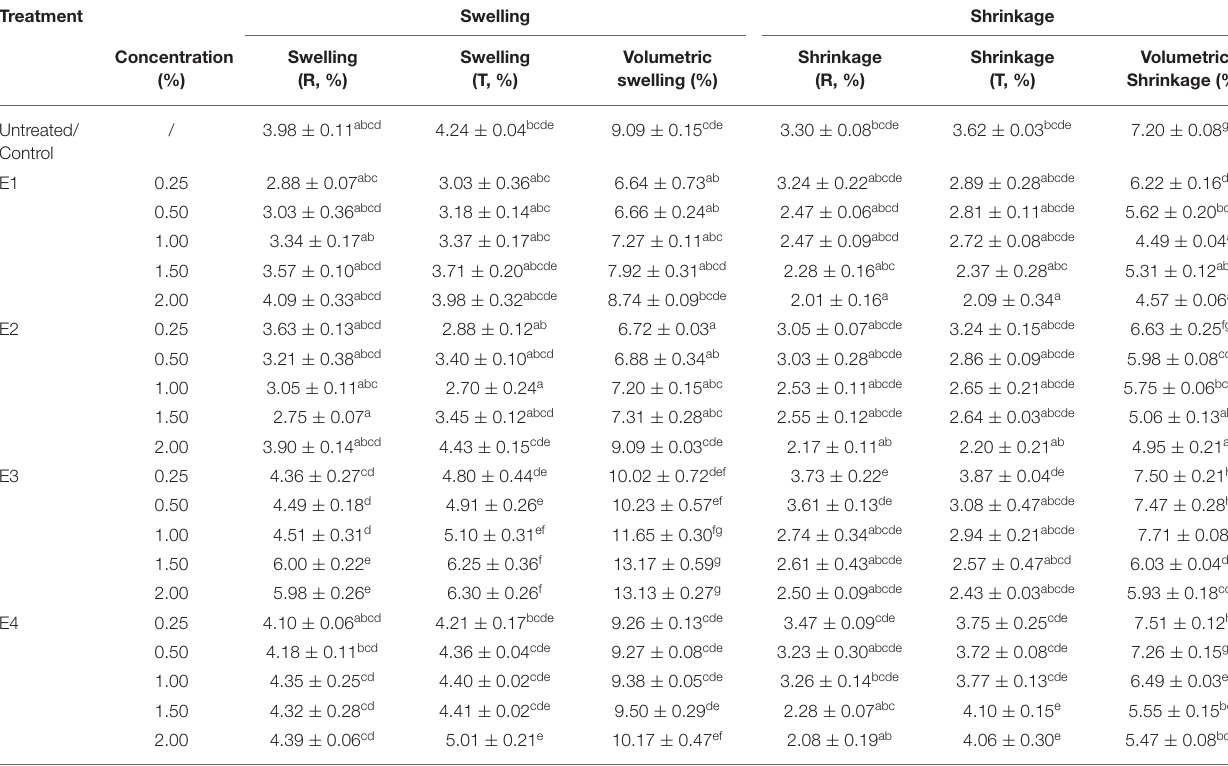
TABLE 2 | Dimensional stability (swelling and shrinkage) of untreated and plant extracts treated wood blocks of Lannea coromandelica . Treatment